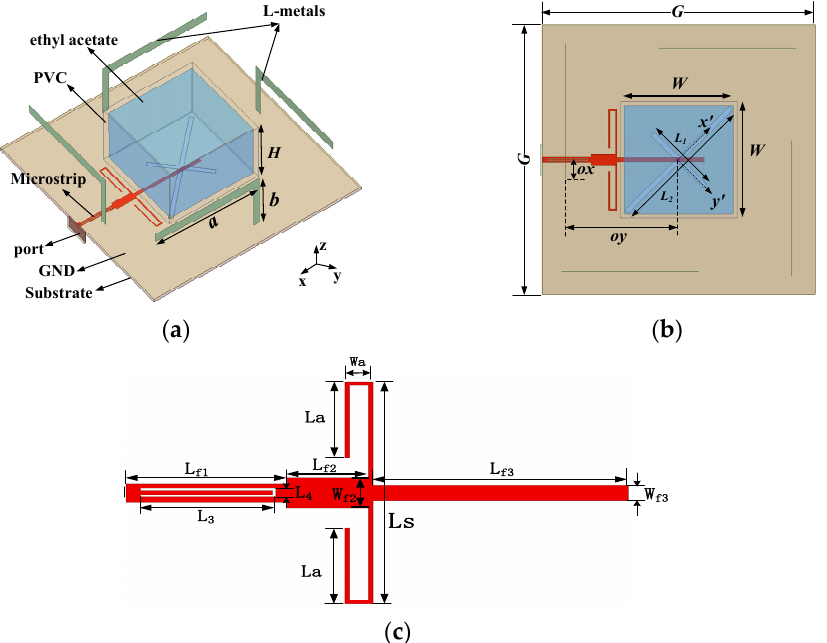
Figure 1. Geometry of the proposed wideband CP filtering antenna. ( a ) Perspective view. ( b ) Top view. ( c ) Configuration of the feeding network. a = 70, b = 30, ox = 10, oy = 60, W = 58, H = 40, L 1 = 38, L 2 = 76, G = 150, L f 1 = 29, L f 2 = 17, L f 3 = 45, L a = 20, L s = 52, W a = 4, W f 2 = 5, W f 3 = 1.6, L 3 = 23, L 4 = 0.9 and all in